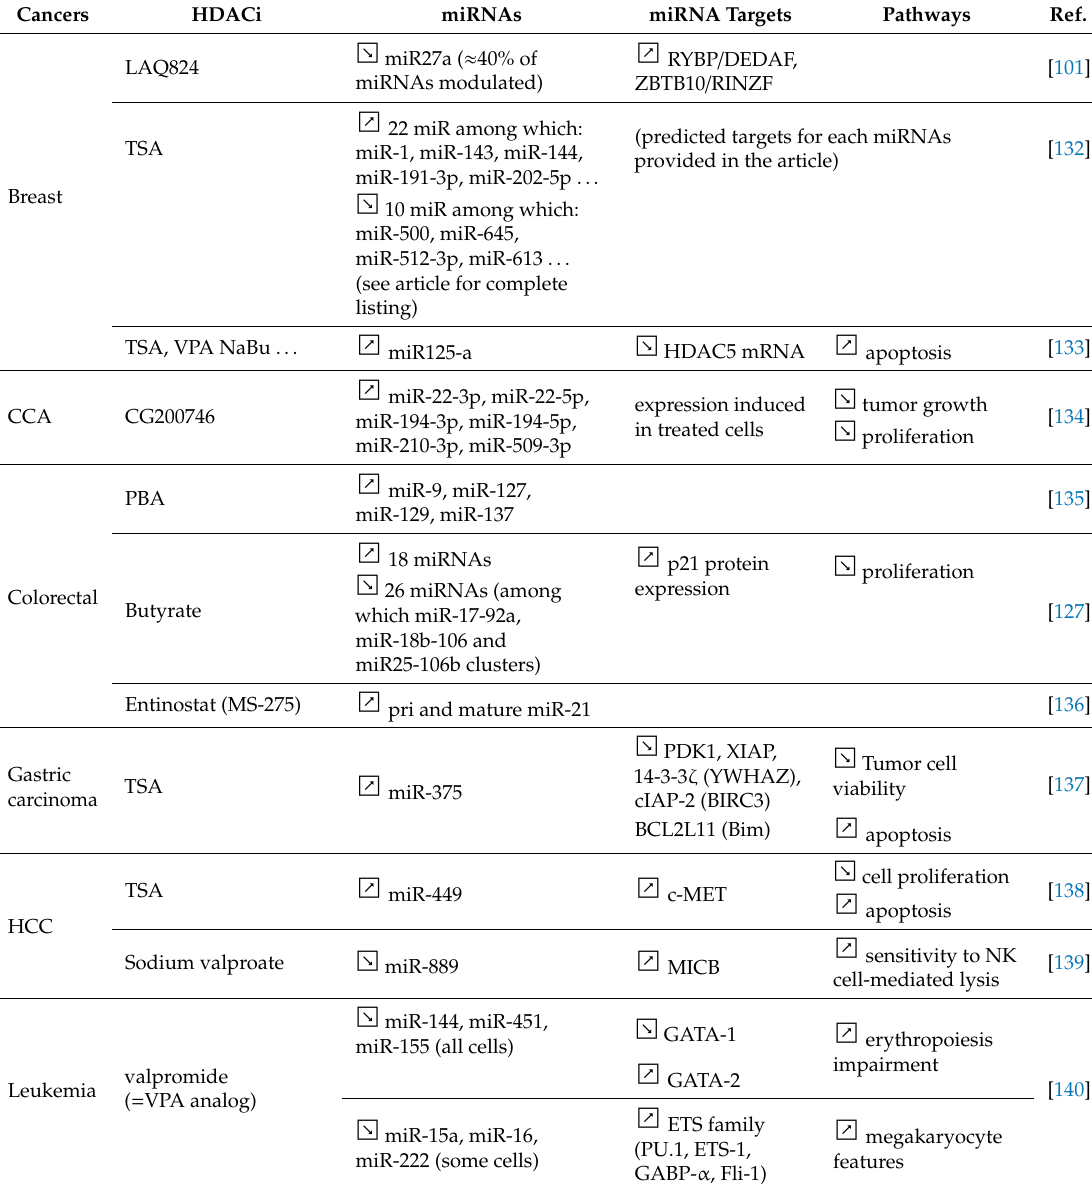
Table 4. microRNAs regulated by the four FDA-approved histone deacetylase inhibitors in cancers. Cancers HDACi